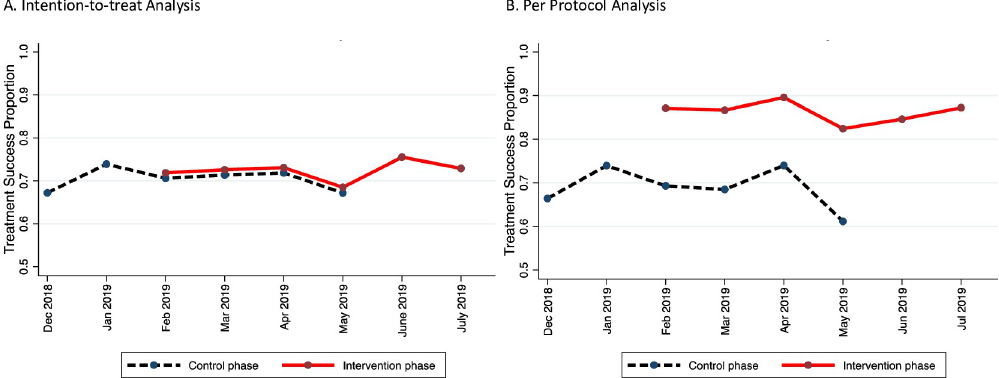
Fig 2. Adjusted proportions of treatment success. The data shown are adjusted proportions output by the primary analysis mixed effects logistic regression model for the (A) intention-to-treat analysis and (B) per protocol analysis.